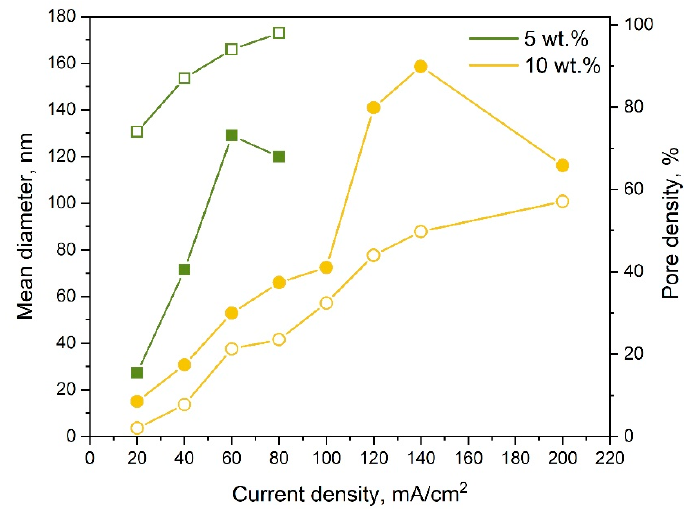
Figure 3. Dependence of the mean diameter (filled symbols) and pore density (empty symbols) on the applied current density of the PS samples formed at different HF concentrations.